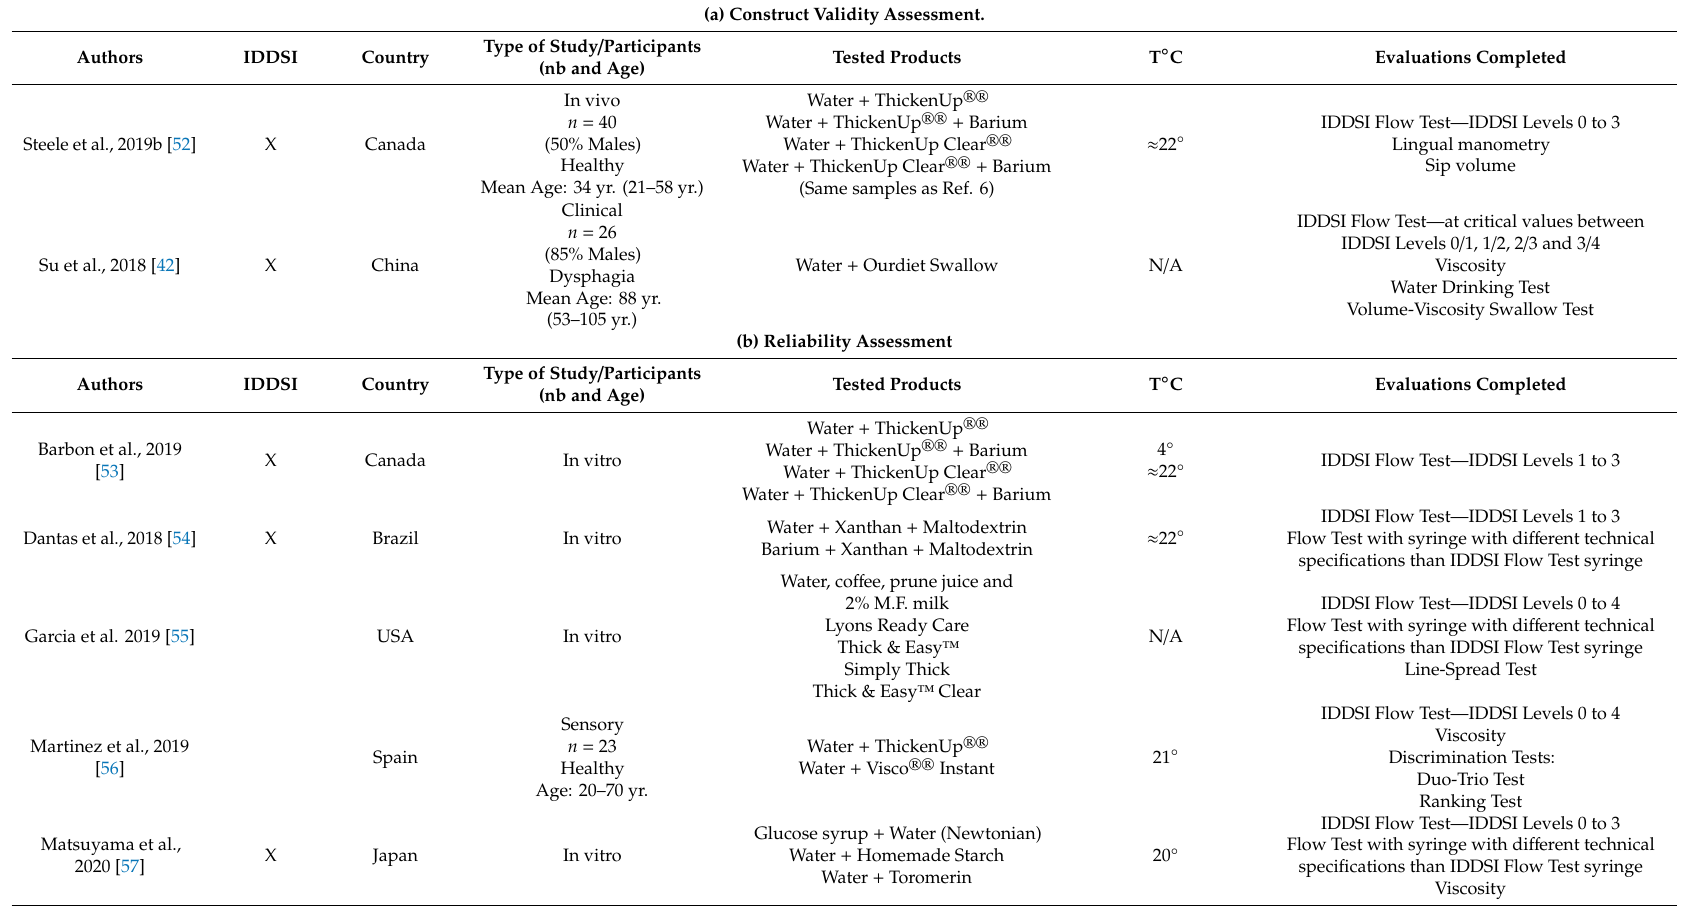
Table 3. Cont . (a) Construct Validity